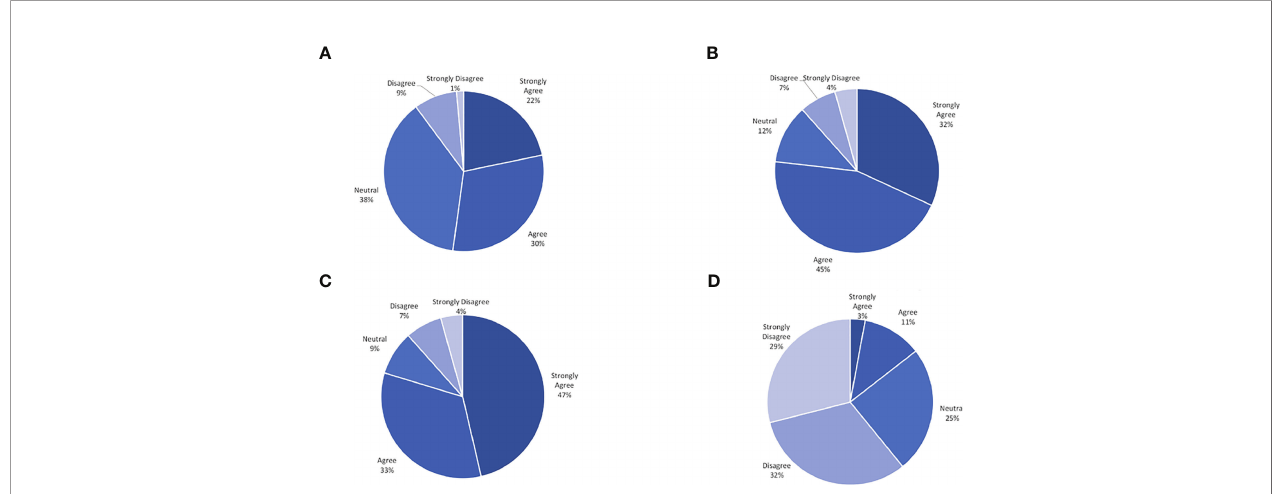
FIGURE 1 | Continous glucose monitor satisfaction survey result. (A) Helps me feel more satis fi ed with my weight management. (B) Gives me information about my glucose that is useful. (C) Helps me identify how food and activity affect me. (D) Makes me feel more frustrated about my weight.